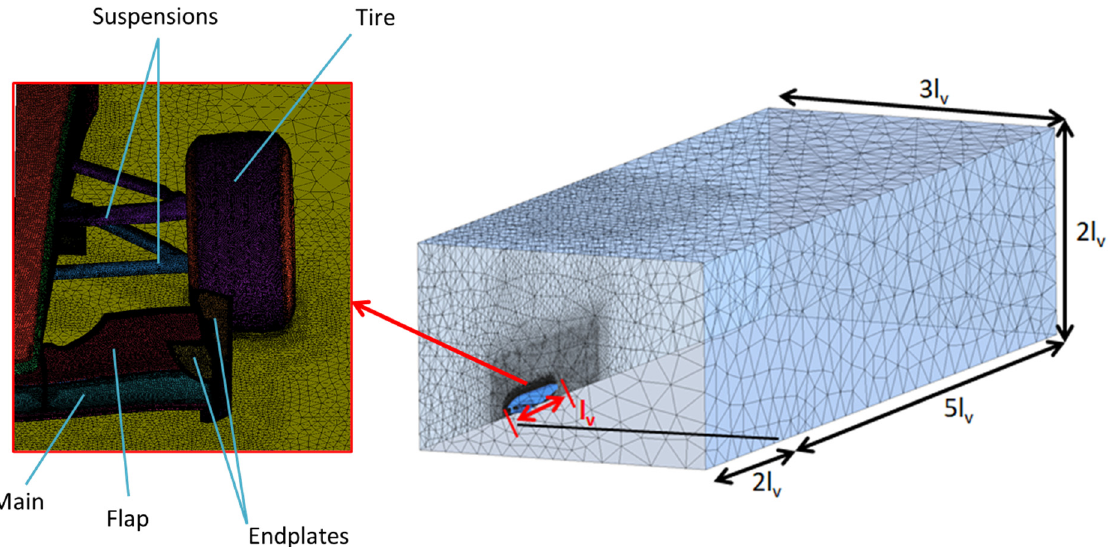
Figure 3. Mesh of the complete model.